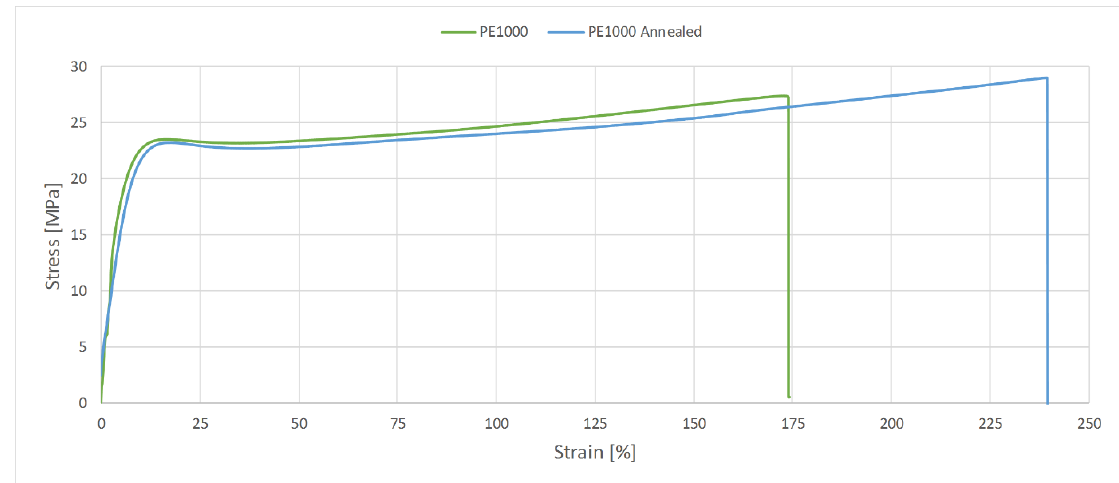
Figure 10. Diagram of the relationship between tensile strength and elongation for PE1000 and PE1000 after heat treatment.